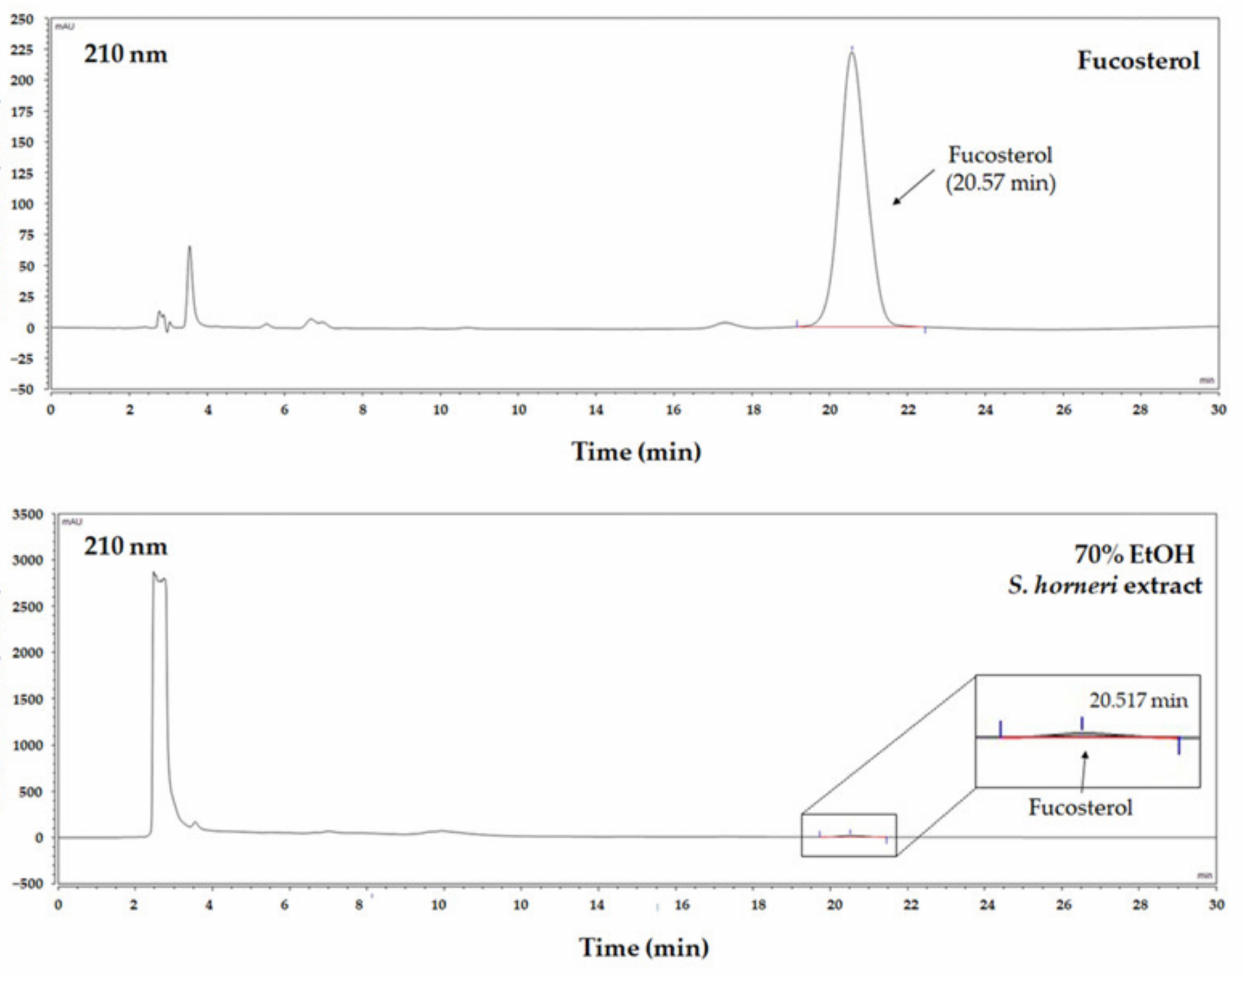
Figure 2. HPLC chromatogram of fucosterol as a standard compound and 70% EtOH S. horneri extract. ( A ) Fucosterol, ( B ) 70% EtOH S. horneri